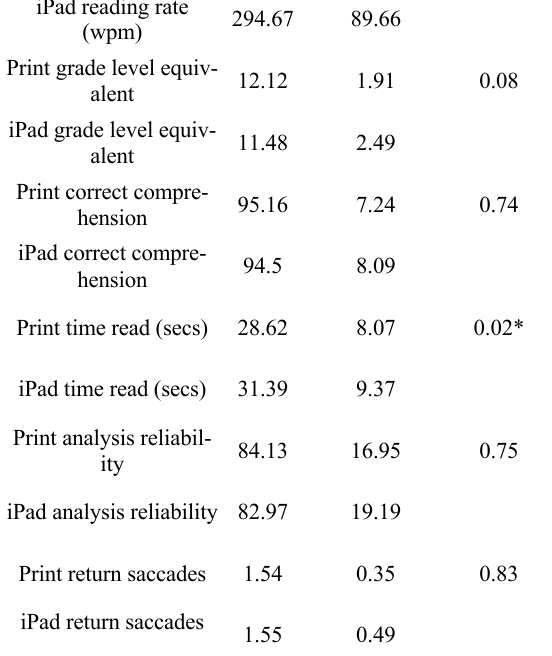
Table 3 for a summary of the percentile scores.